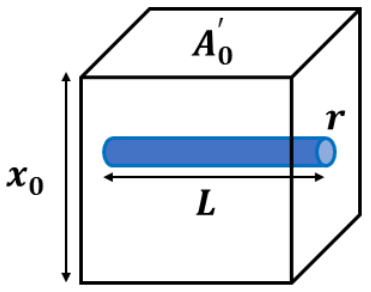
Figure 1. An ideal model of an elastic, isotropic block with a single interior fluid-filled channel of radius 𝑟 and length 𝐿 is considered for the stress derivation in the MCFM. The block cross-sectional area and height are denoted by 𝐴 0′ and 𝑥 0 , respectively. It is assumed that the channel is open to free exit of fluid volume only on one side, and the flow fluid is governed by Poiseuille’s law.